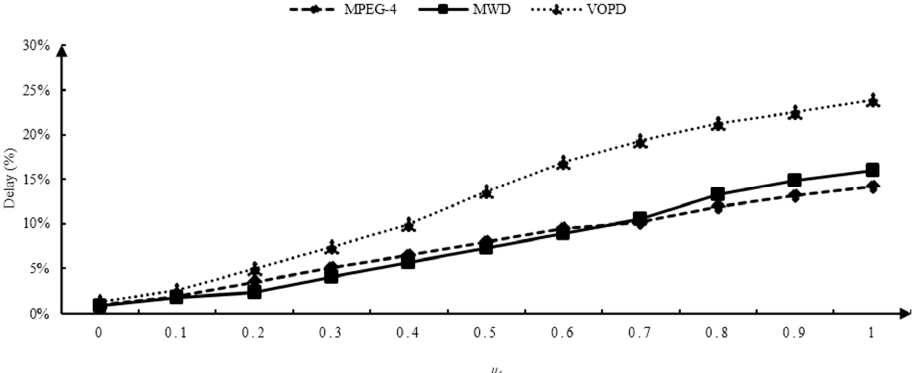
Figure 15. Influence of multi-objective optimization parameter μ d on delay optimization results.